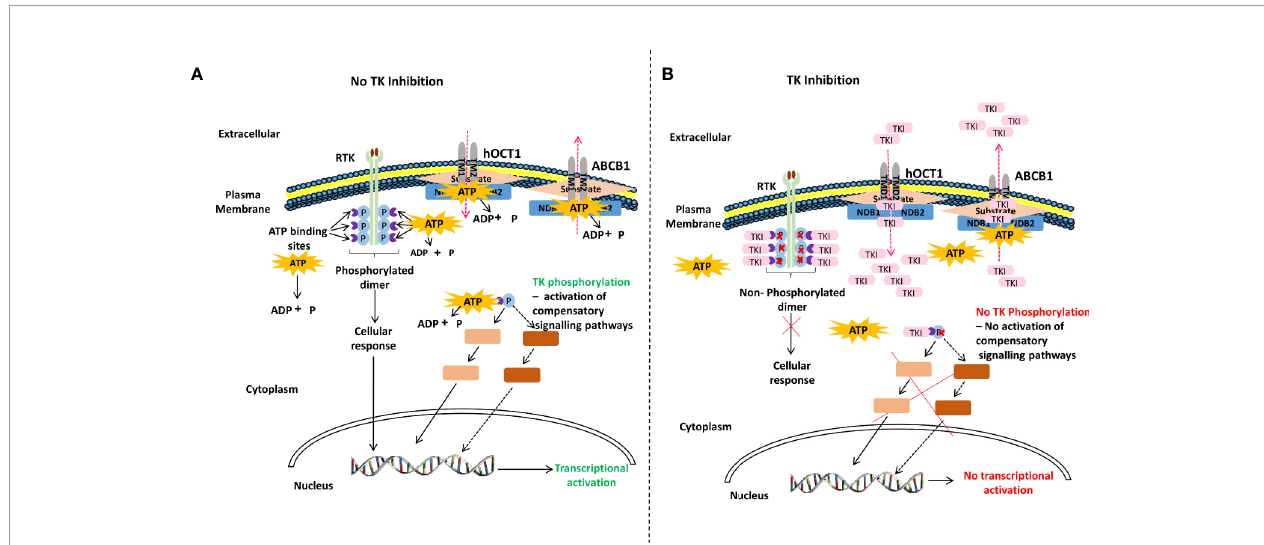
FIGURE 2 | A generalized proposed mechanism of action of tyrosine kinase inhibitors (TKIs). (A) auto-phosphorylation of receptor TK (RTK) (light green) upon ligand (brown) binding activates TKs (purple) downstream leading to transcriptional activation. RTK functions by binding ATP and transferring phosphate from ATP to tyrosine residues on various substrates, which leads to their phosphorylation and subsequent cellular response; such as the excess proliferation of cells. Intracellular non-RTKs can also bind ATP and transfer phosphate from ATP to tyrosine residues on various substrates, which can also lead to their phosphorylation and subsequent cellular response. The plasma membrane also has in fl ux and ef fl ux transporters that are ATP-gated (left hand panel). (B) In the absence of TK activity, substrates necessary for RTK function cannot be phosphorylated and consequent cellular events are abrogated. Hence, TKIs function by binding to ATP-binding catalytic sites of the TK domains on RTKs or on non-RTKs, thereby, preventing TK phosphorylation and inhibiting down-stream intracellular signaling and transcription of genes such as pro-in fl ammatory cytokines. TKIs can also bind and occupy ATP- or substrate-binding sites on transmembrane transporters such as the hOTC1 in fl ux protein and the ABC ef fl ux pumps (64 – 66), thereby, affecting drug and cellular responses (right hand panel). RTK, receptor tyrosine kinase; TK, tyrosine kinase; hOCT1, human organic cation transport member 1; ABC, ATP-binding cassette; ABCB1, ABC sub-family B member 1 (P-glycoprotein 1); ATP, adenosine triphosphate; ADP, adenosine diphosphate; p, phosphate; NDB1, nucleotide binding domain 1; NDB2, nucleotide binding domain 2; TMD1, transmembrane domain 1; TMD2, transmembrane domain 2; TKI, tyrosine kinase